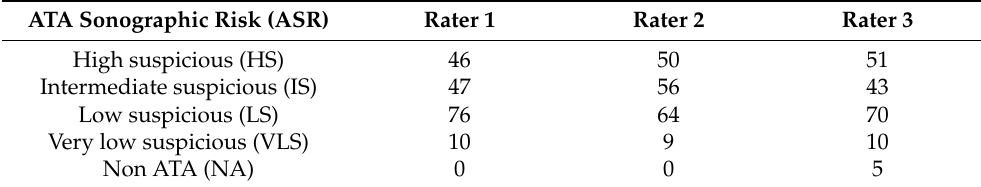
Table 3. Interpretation of ATA sonographic risk per rater.